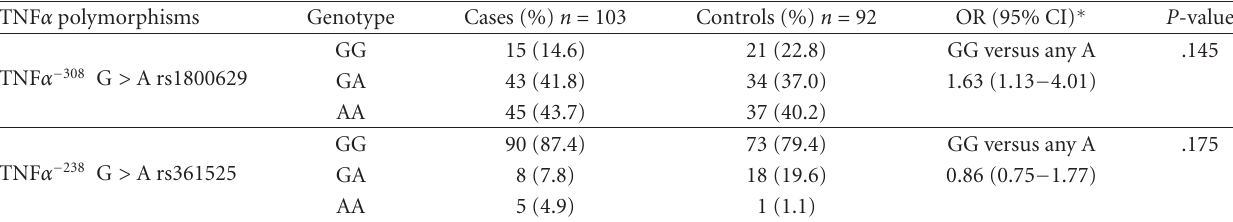
Table 2: Genotype frequencies of TNF α among cases and controls and the association with AP risk. ORs with 95% CI and P -values were calculated for wild/wild genotype versus wild/mutant and mutant/mutant